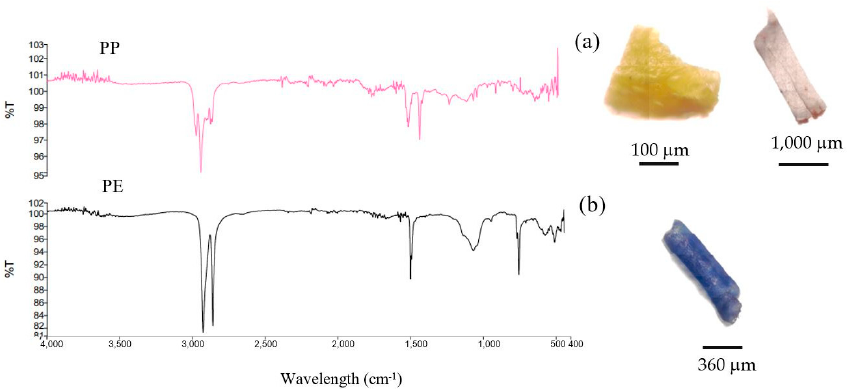
Figure 5. Microplastic fragment polymer types analyzed using FTIR spectra; ( a ) polypropylene (PP), ( b ) polyethylene (PE).